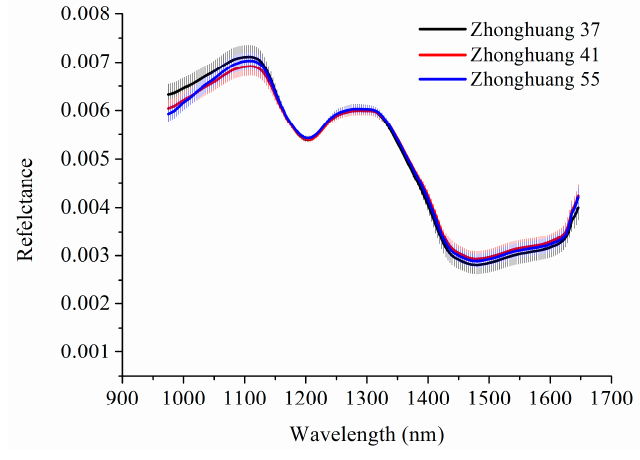
Figure 4. Average spectra with SD of three varieties of soybeans.